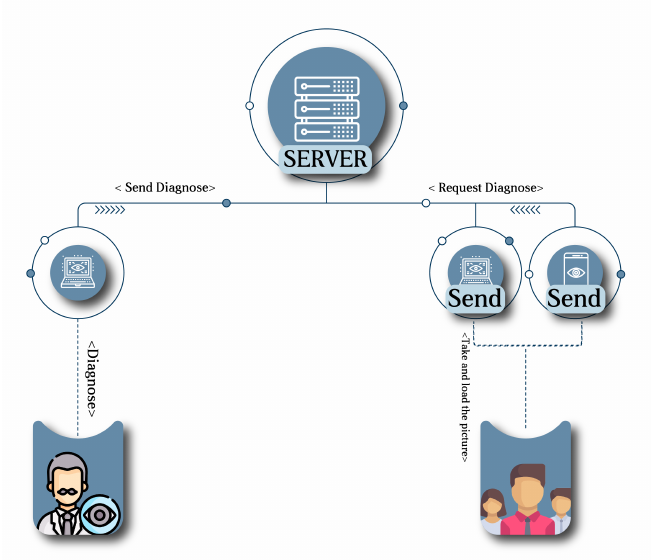
Figure 2. Model explaining communication between the patient and specialist. The patient can send images through their cellphone or computer.